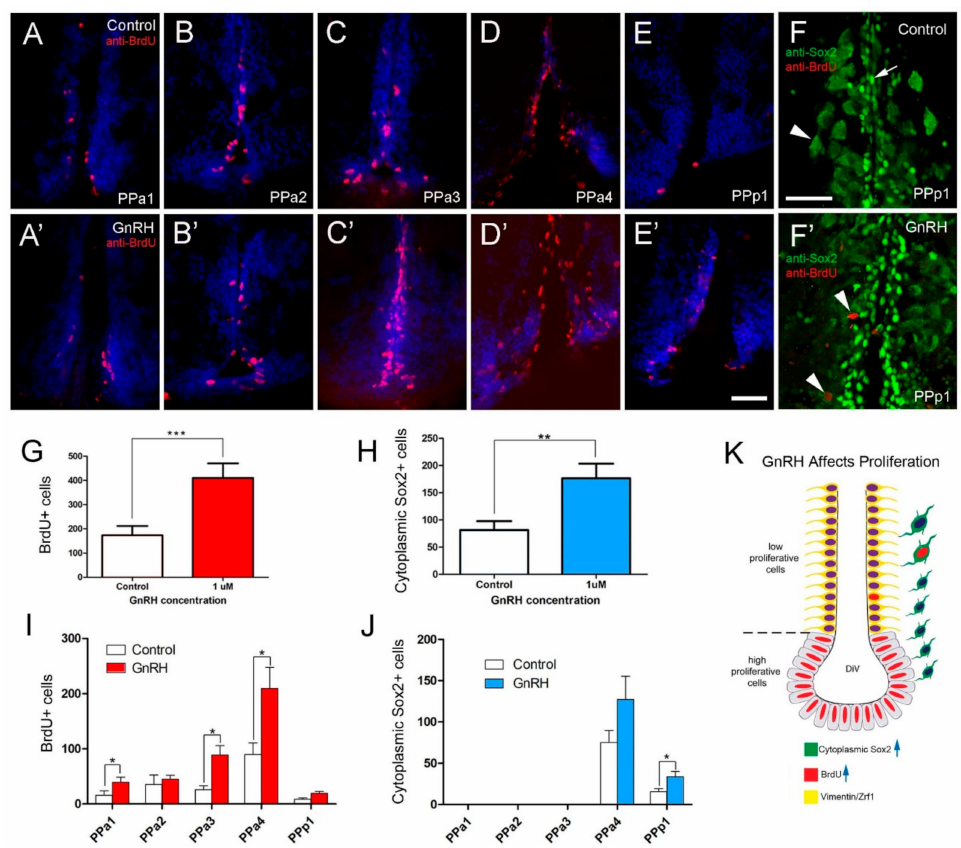
Figure 8. BrdU labeling reveals GnRH-induced increases in cells in the POA. ( A – E , A’ – E’ ) Quantifi- cation of the effects of GnRH (1 µ M GnRH) on the POA of adult zebrafish: Cells were counted in transverse 20 µ m cryosections of the POA (12 sections). ( A – E ) GnRH control. ( A – E’ ) GnRH treatment (1 µ M GnRH). ( F ) Control with Sox2+ cells (arrow), cytoplasmic Sox2+ (arrowhead) ( F’ ) GnRH treatment increased cytoplasmic Sox2+ cells in the PPp1 (arrowheads). ( G ) Significant increases in BrdU labeled cells in the GnRH-treated animals. ( H ) Significant increases in cytoplasmic Sox2+ cells increased in the GnRH-treated animals. *** p < 0.001; ** p < 0.01; Student’s t -test, SEM. ( I , J ) Number of cells located in the regions of the POA scored in transverse cryosections (20 µ m: PPa1 = 2, PPa2 = 2, PPa3 = 3, PPa4 = 4 and PPp1 = 2). ( I ) Number of BrdU+ cells ( J ) number of cytoplasmic Sox2+ cells in GnRH-treated animals. * p < 0.05, Student’s t -test, SEM. ( K ) GnRH treatment increased the number of BrdU+ cells (blue arrow) and cytoplasmic Sox2+ (blue arrow) cells, where few cytoplasmic